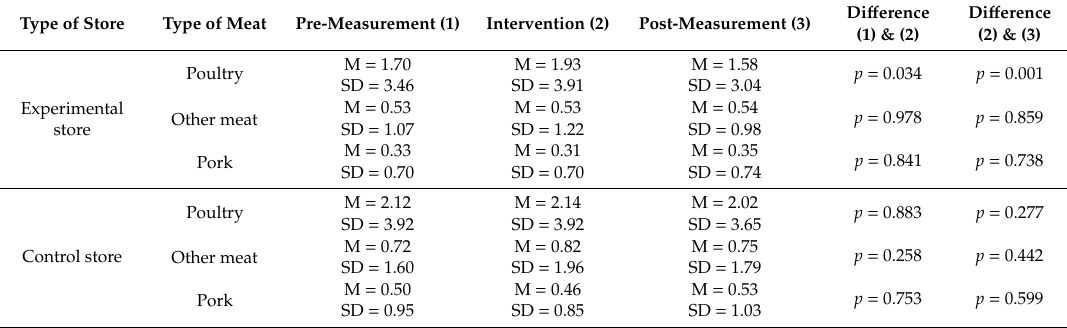
Table 1. Amount of meat (kg) sold per product per